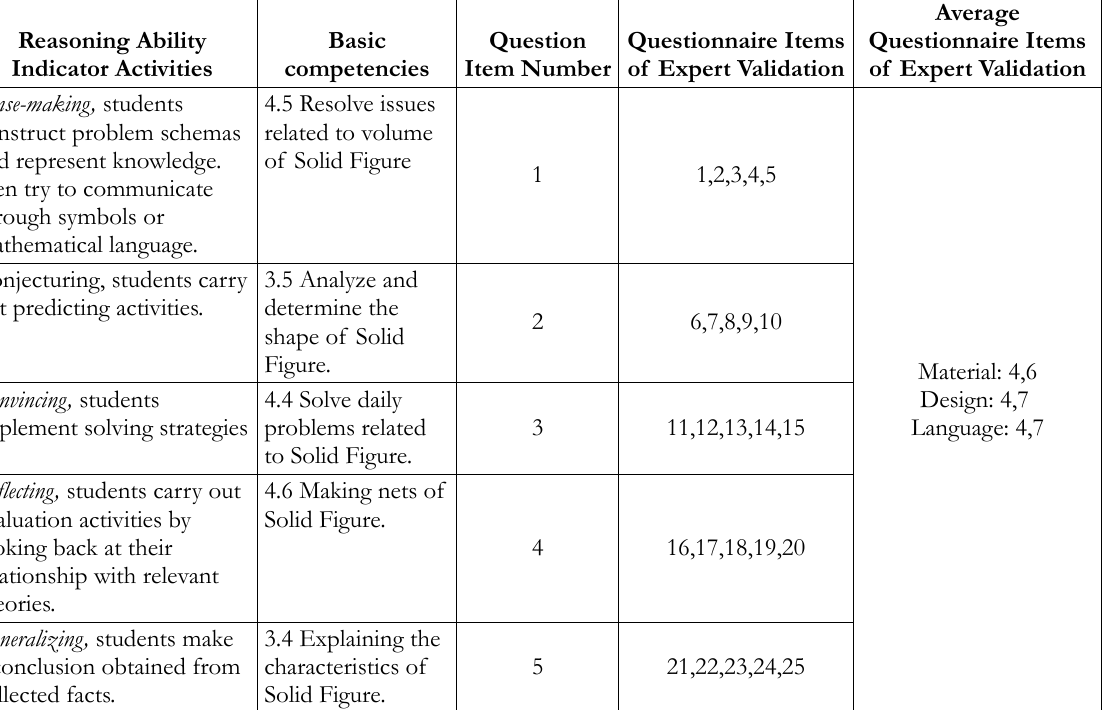
Table 9. Questionnaire Items of Expert